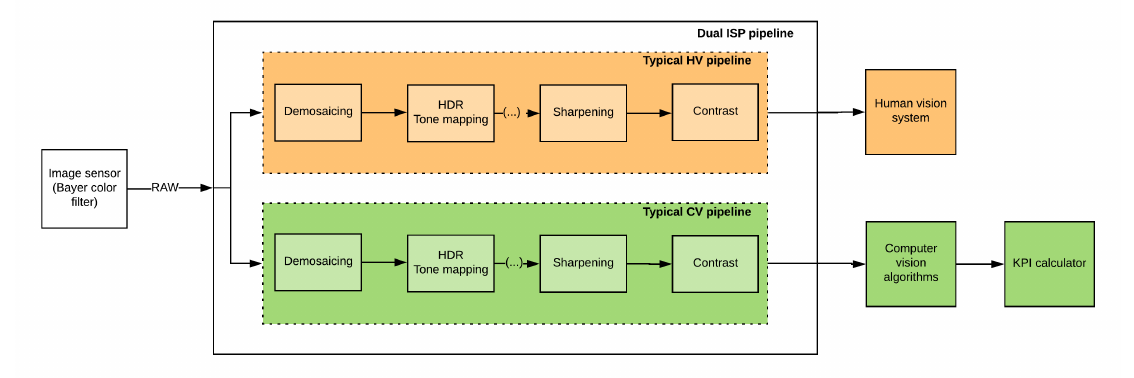
Figure 19. Illustration of Dual